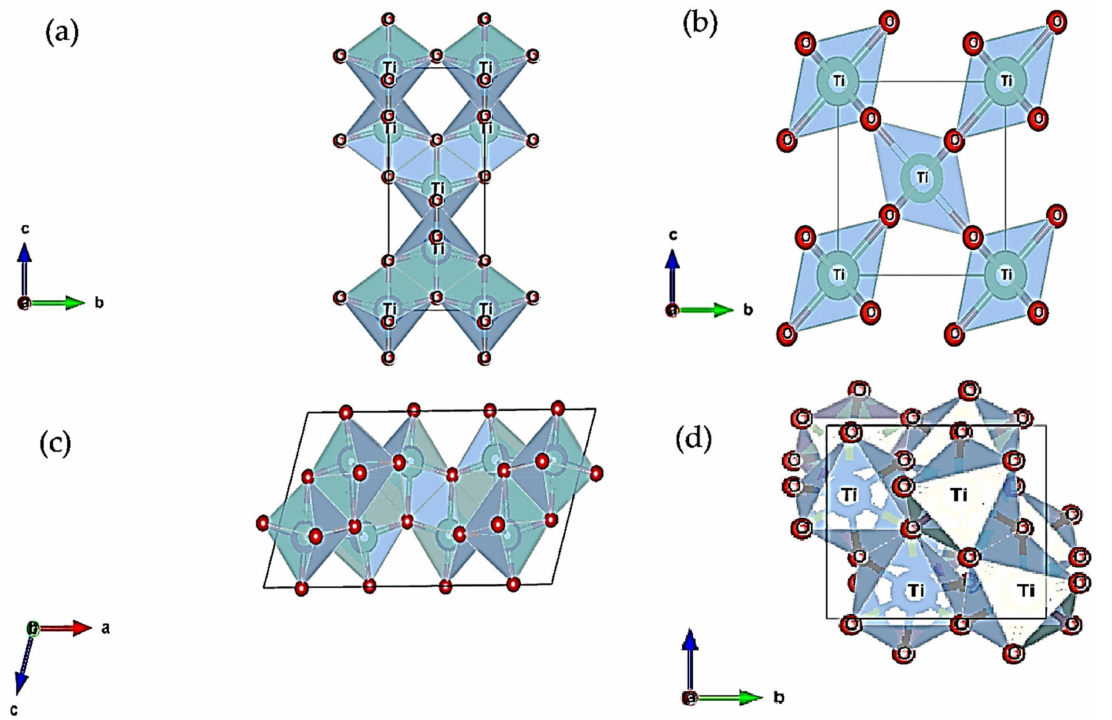
Figure 5. The crystal structures: ( a ) anatase, ( b ) rutile, ( c ) TiO 2 -B, and ( d ) brookite. Influence of Experimental Conditions on TiO 2 Crystal